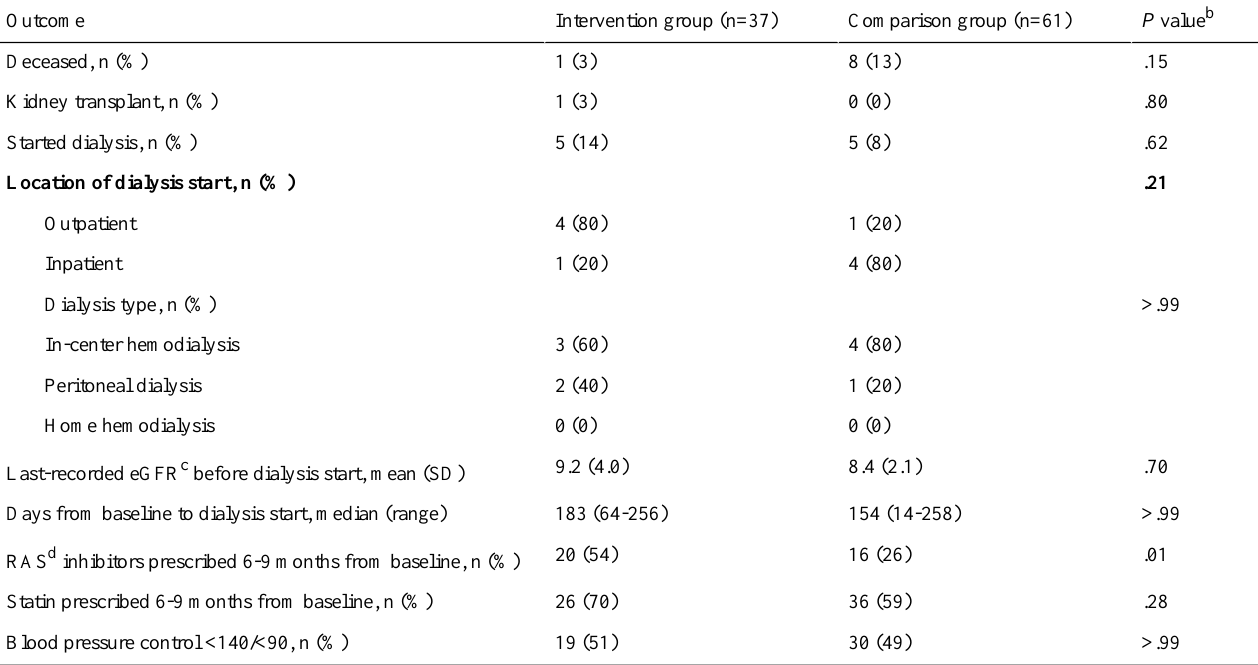
Table 3. Outcomes at nine months after baseline.